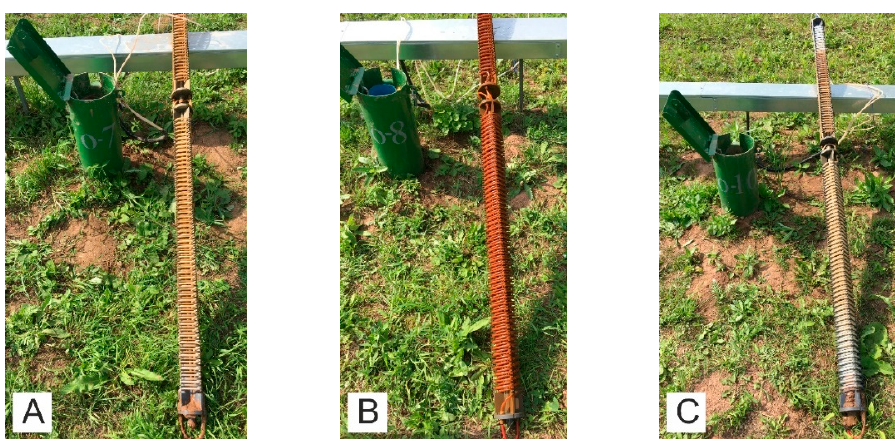
Figure 6. Newly formed film on emitter tubes during oxygen delivery operation: ( A ) well 7-o; ( B ) well 8-o; and ( C ) well 10-o.